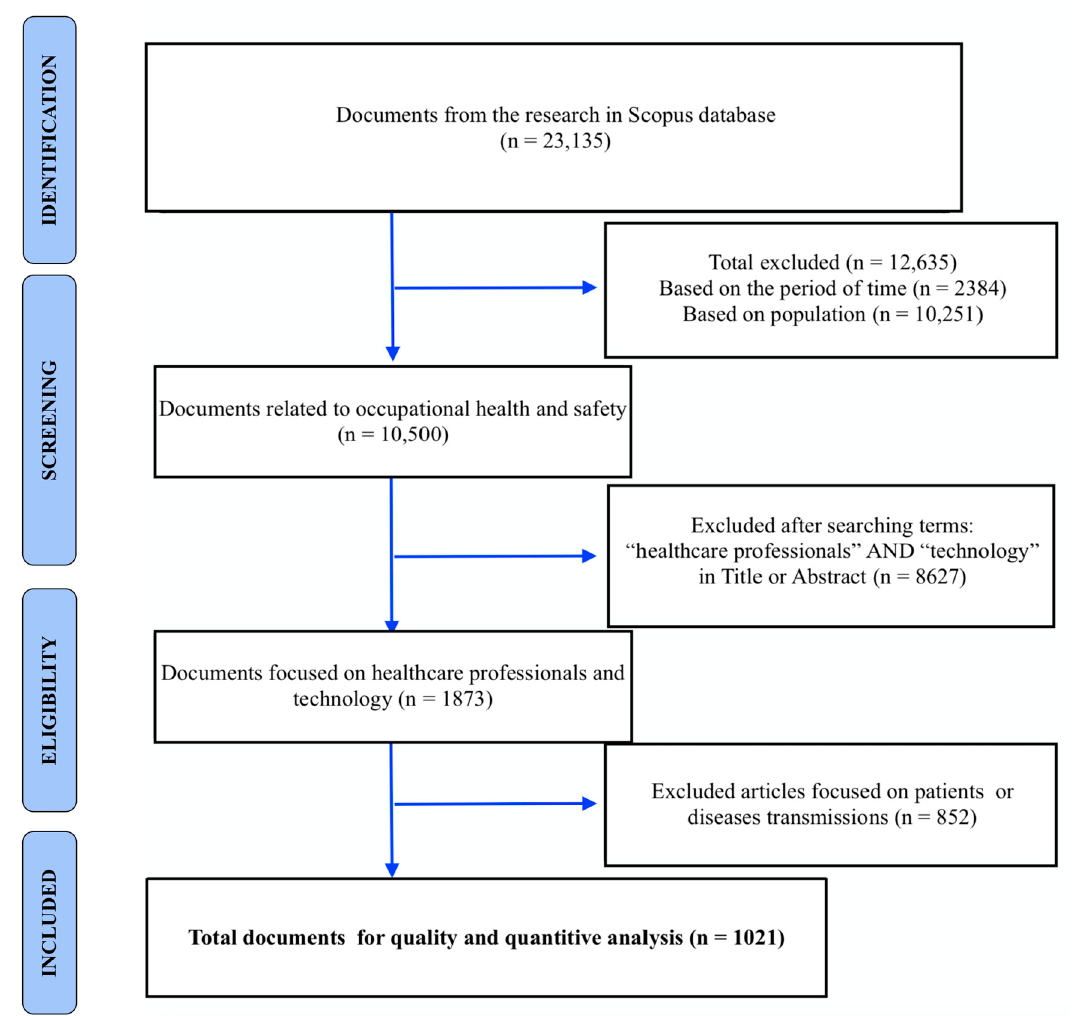
Figure 1. Flow diagram of the selection of articles for the quantitative and qualitative analysis.